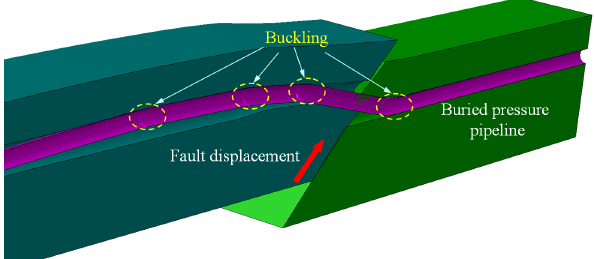
Figure 8. Deformations of the buried pressure pipeline and sur- rounding soil.